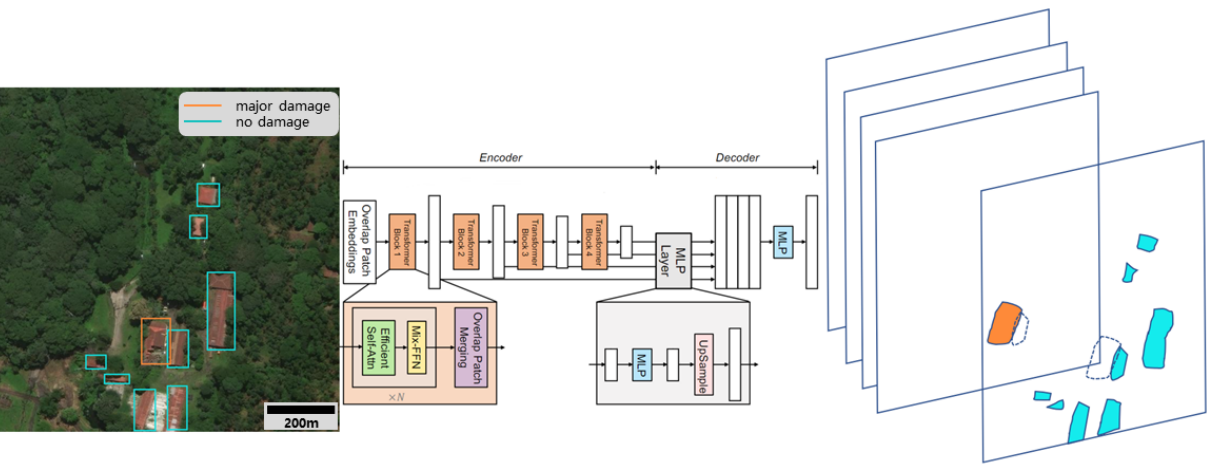
Figure 5. Overall model structure of SegDetector, which is based on SegFormer, to implement sub- channel target detection. sub-channel target